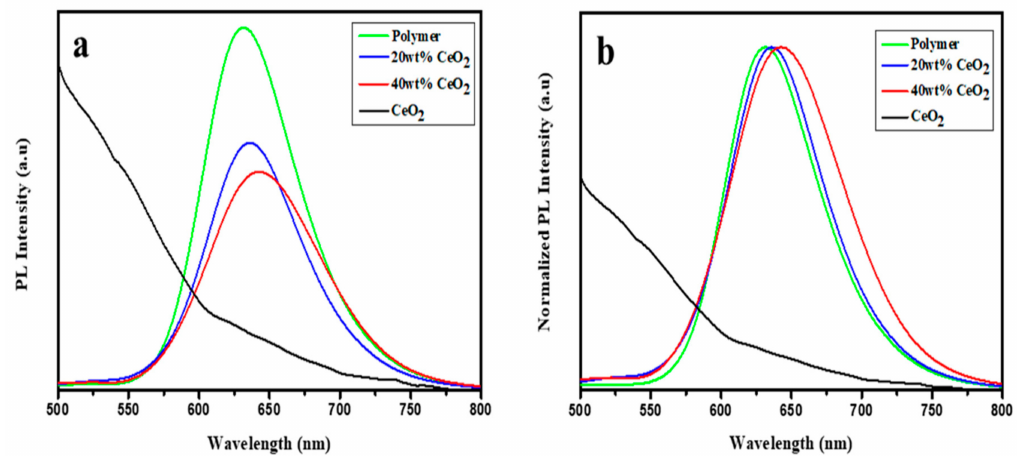
Figure 6. ( a ) The photoluminescence emission spectra and ( b ) the normalized spectra of CeO 2 , polymer, polymer composite with 20 wt% and 40 wt% CeO 2